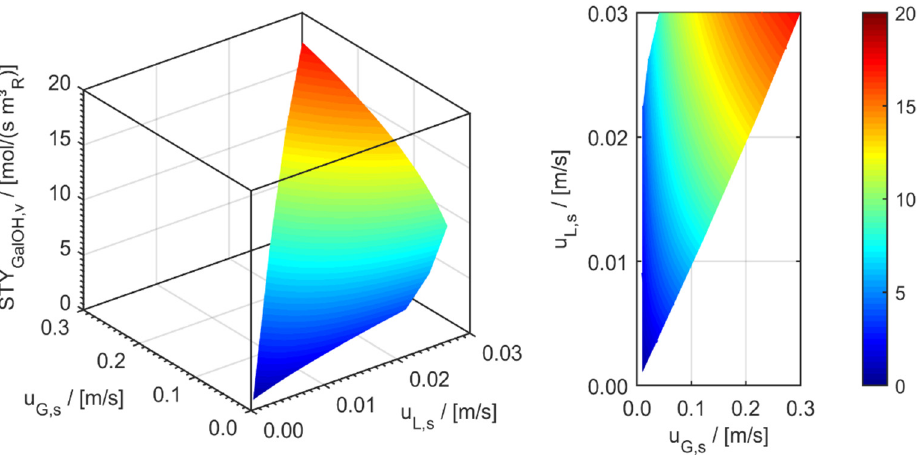
Figure 18. Volumetric space-time yield referring to galactitol in mini trickle-bed reactors operating at different gas and liquid superficial velocities.